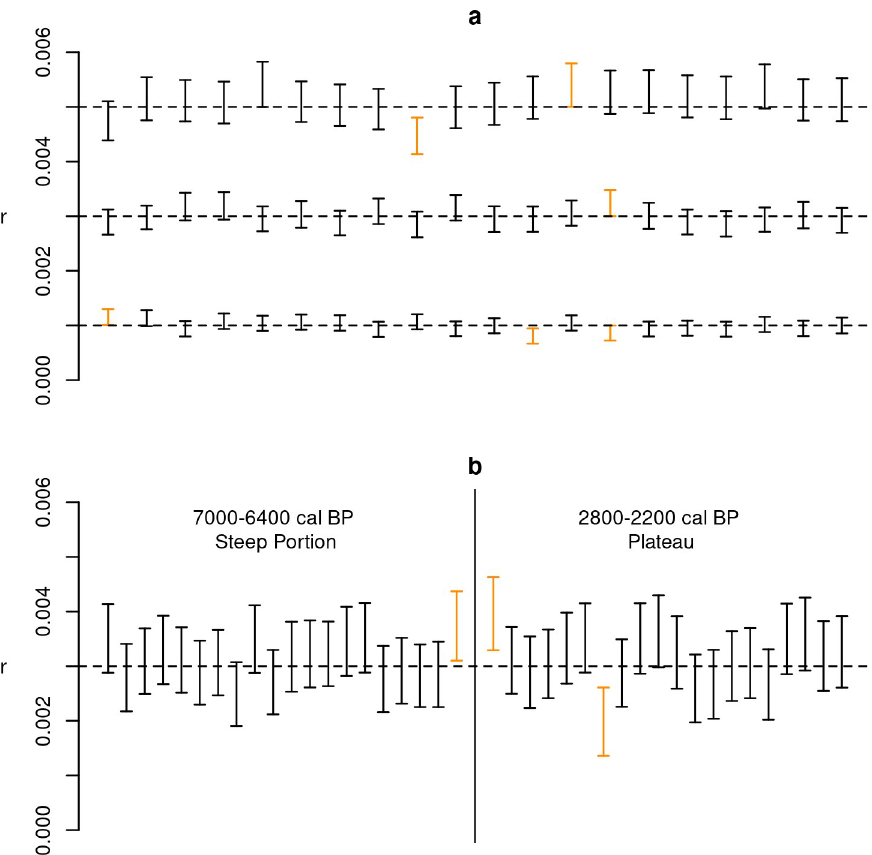
Fig 3. Results of experiments 1 & 2. Error bar represents the estimated 90% HPD interval for each run; cases where the true parameters were not within the interval are displayed in orange. https://doi.org/10.1371/journal.pone.0251695.g003 growth rate r with a median posterior of 0.0014, i.e. an annual growth rate of 0.14%. Growth estimates of r in models m2 and m3 , which most likely captures the growing population 2 trend during the Yayoi period, yielded slightly higher estimates approaching an annual growth